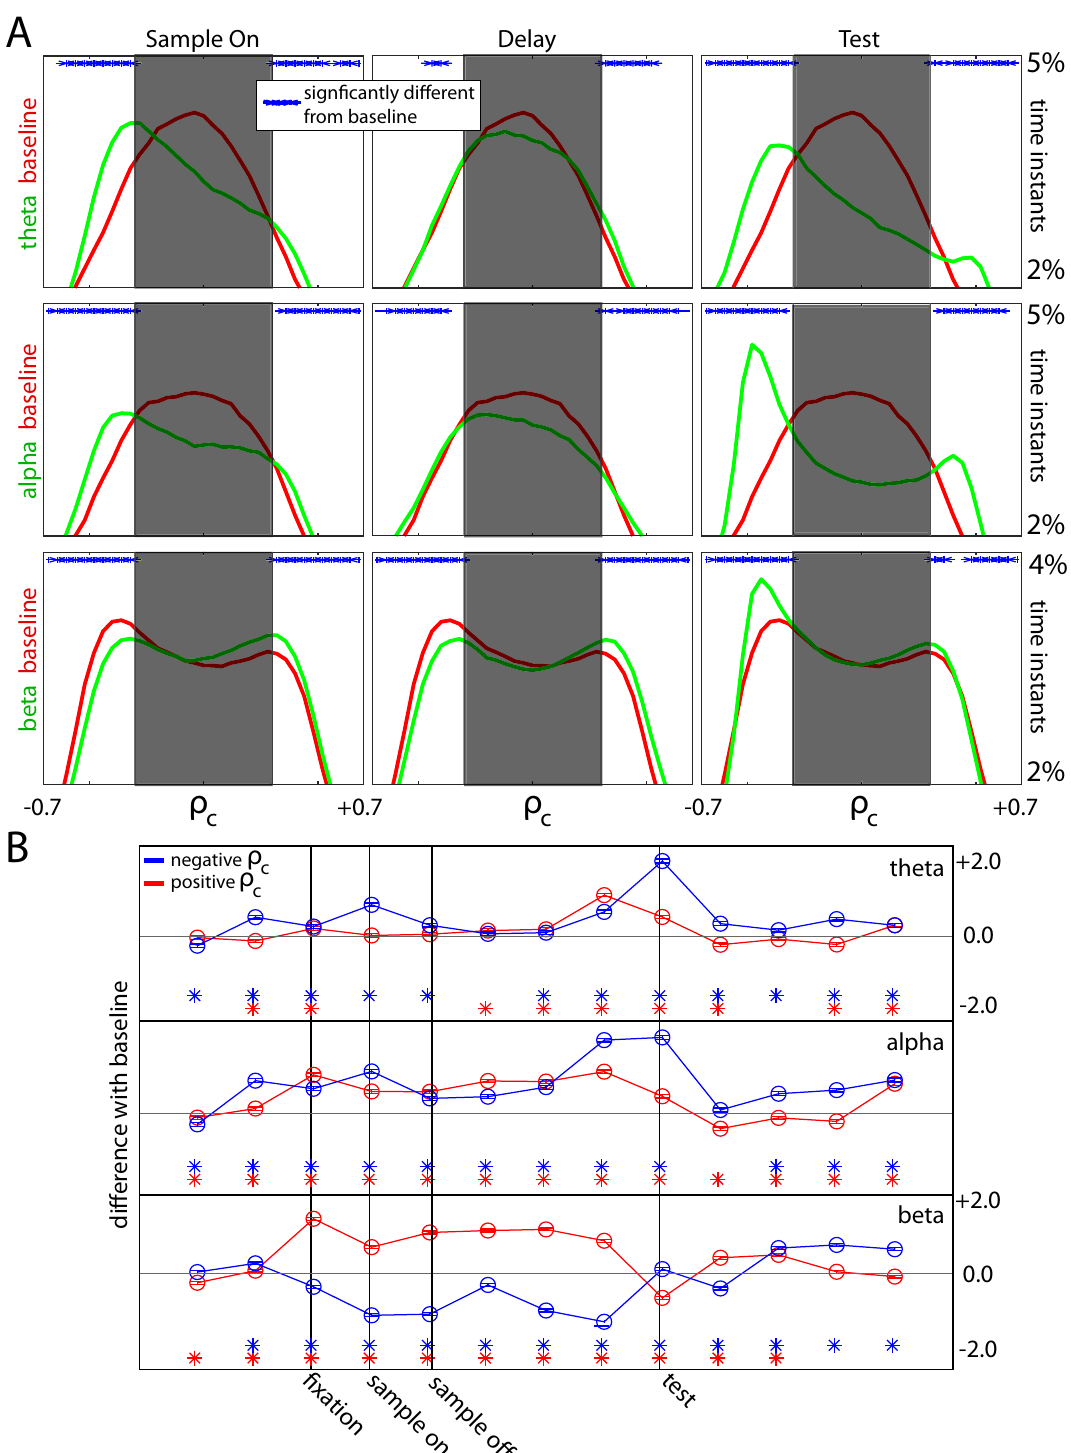
Fig 4. (A) Histograms quantifying the correlation values seen on average in each trial during the sample, delay, and test-onset intervals (all 0.5 s in length), combined across arrays. A correlation value to the right of the shaded region (positive) denotes waves in a particular direction, while the left means the opposite direction. The shaded region denotes the “chance zone” where no conclusion regarding wave direction can be made. For each frequency range (each row), the red histogram corresponds to the